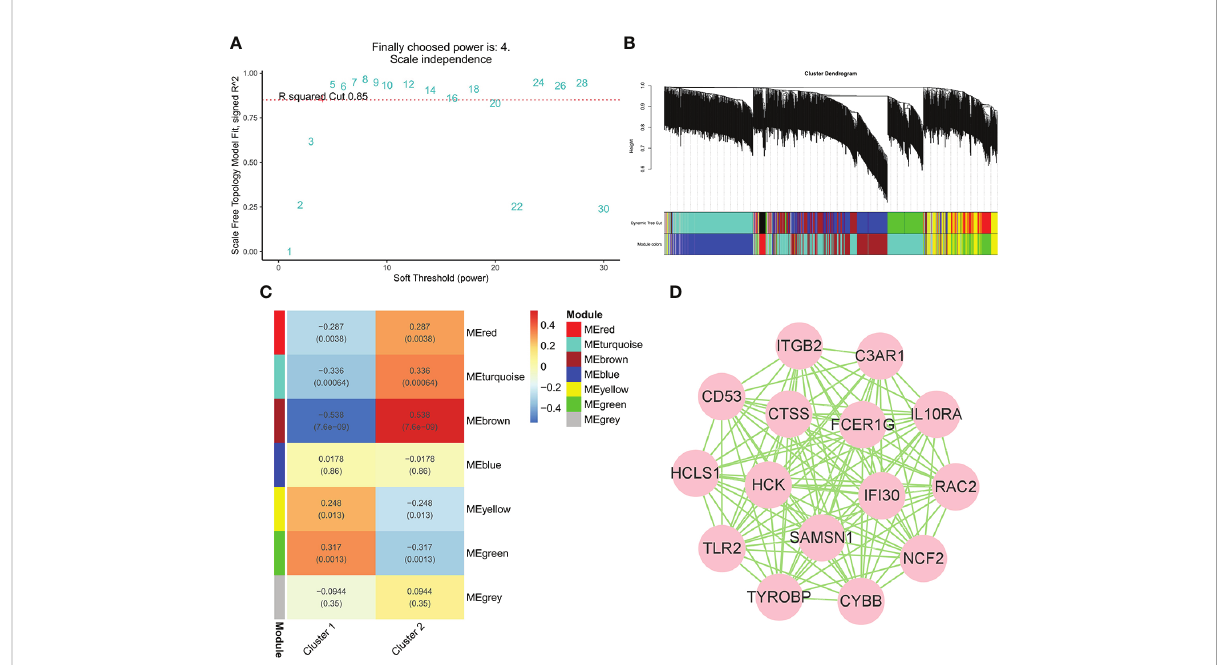
FIGURE 5 WGCNA of IgAN clusters in data. (A) Identi fi cation of soft threshold, b = 4 was considered the most suitable. (B) The cluster dendrogram of co- expression genes in clusters of 100 IgAN samples. (C) Module – trait relationships in clusters of 100 IgAN samples. Each cell contains corresponding correlation and p-value. (D) The network of 15 hub genes in the brown module based on MM =